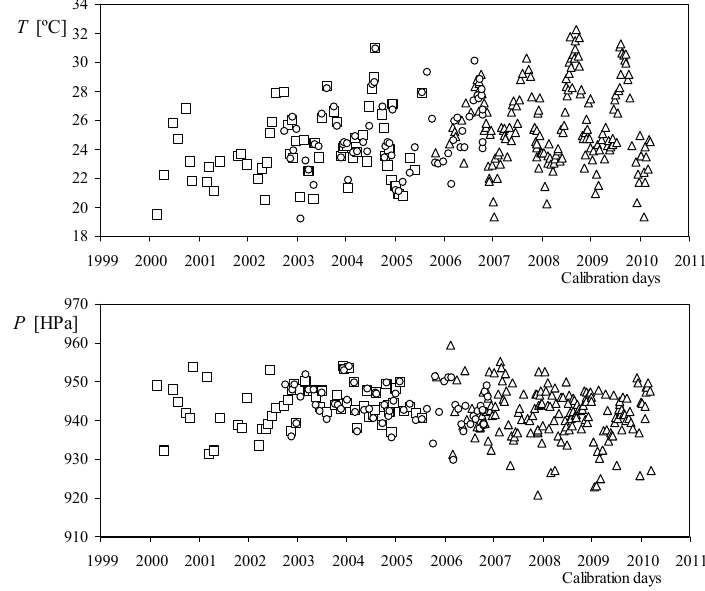
Figure 11. Climatic conditions and air density during calibrations performed on the anemometers used at the IDR/UPM Institute for quality control procedures: Climatronics 100,075 (squares), Vector instruments A100 L2 (circles), and Thies Clima 4.3350 (triangles), from January 2001 to February 2010. From